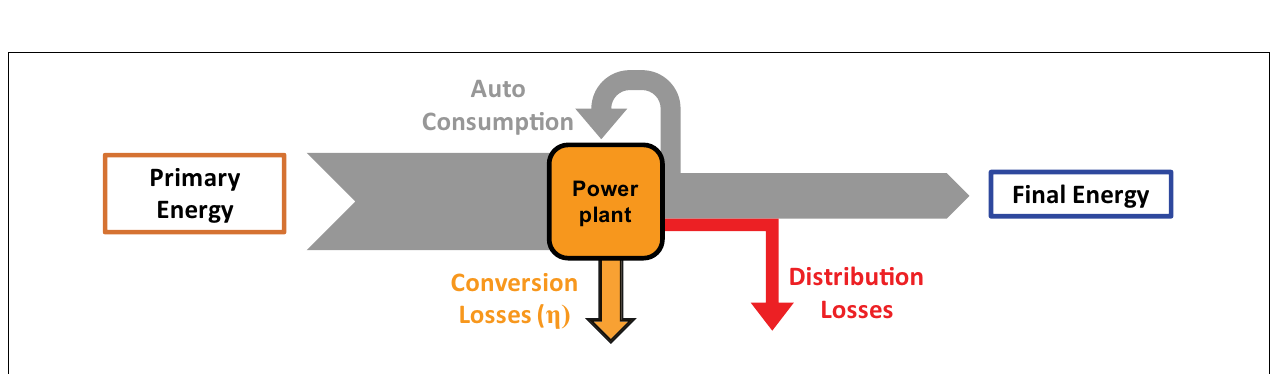
FIGURE 2 | Losses from primary to final energy .